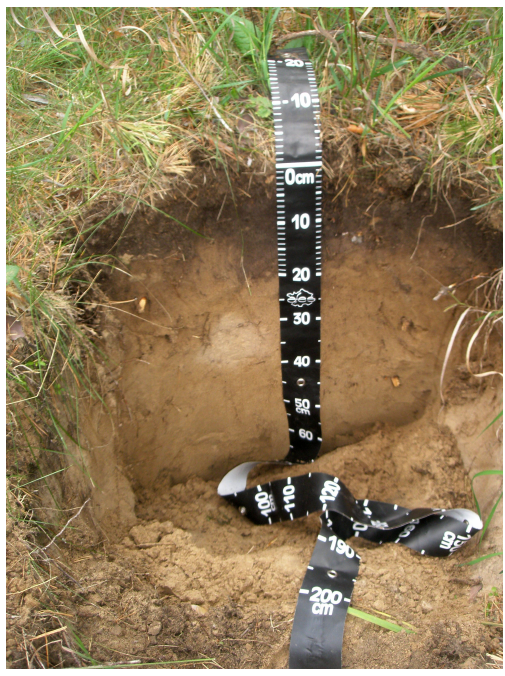
Figure 3. Control